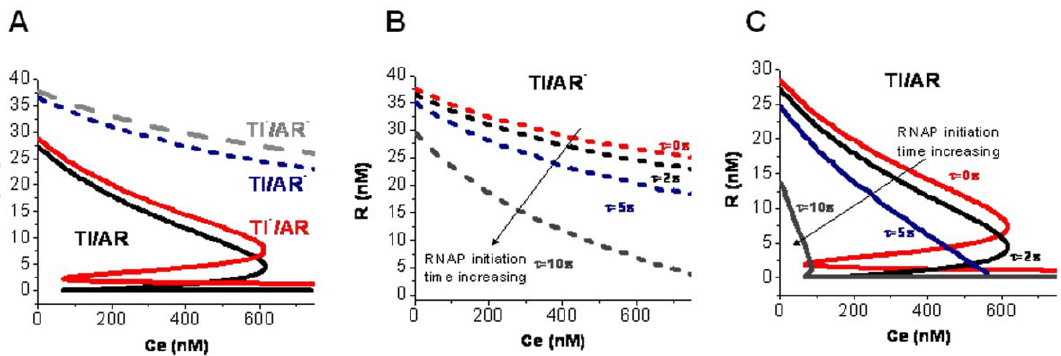
Figure 5. Relative contribution of RNAP collision and antisense regulation effects to bistable switch response. ( A ) Bistability is lost in the absence of TI and antisense RNA interaction effects (TI 2 /AR 2 ). In presence of only TI effects (TI/AR 2 ), the bistable behavior is lost, system ceases to behave as a switch. Bistability is restored when only antisense RNA interaction between full-length RNA is considered in absence of RNAP collision (TI 2 /AR). The system exerts tighter regulation on ScbR expression in presence of convergent transcription (TI/AR). ( B ) Steady state expression level of repressor R to extracellular SCB1 in presence of TI effect only for different RNAP initiation time ( t ) at promoter pA and pR. ( C ) Steady state expression level of repressor R to extracellular SCB1 in presence of both TI and AR effects for different RNAP initiation time ( t ) at promoter pA and